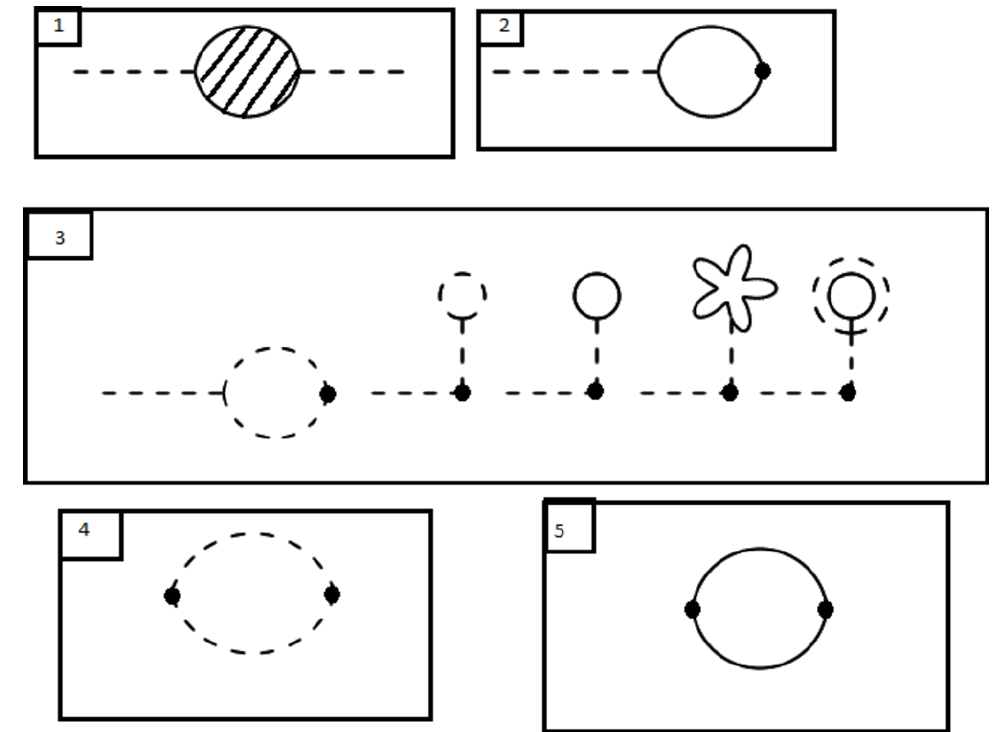
Figure 15 . One-loop contributions to the propagator h O ( p ) O ( (cid:0) p ) i . Wavy lines represent the photon (cid:12)eld, dashed lines the Higgs (cid:12)eld, solid lines the Goldstone boson and double lines the ghost (cid:12)eld. The (cid:15) indicates the insertion of a composite